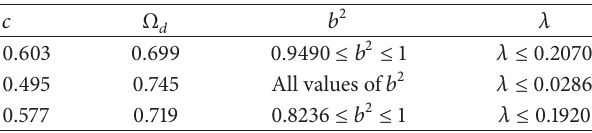
Table 4: Constraints on 𝑏 2 and 𝜆 for GSLT to hold in case of apparent horizon.